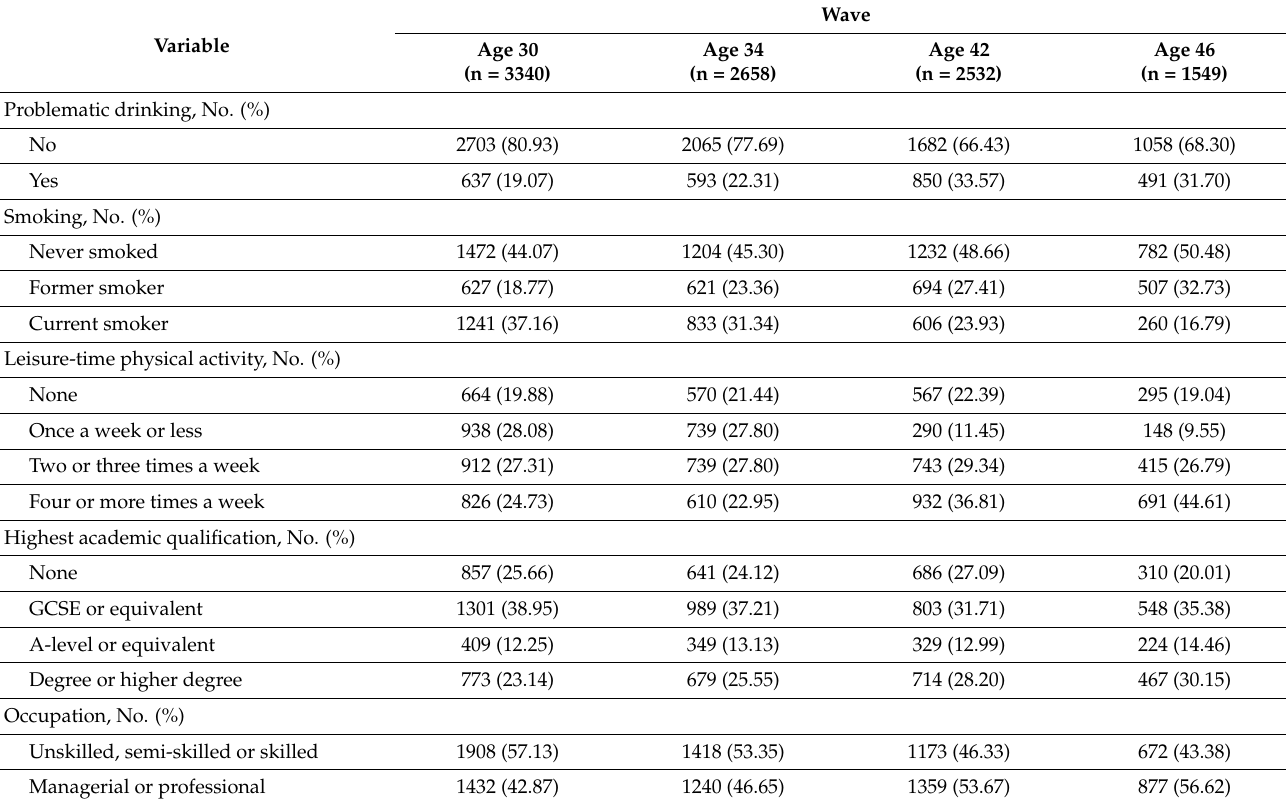
Table 1. Male participants’